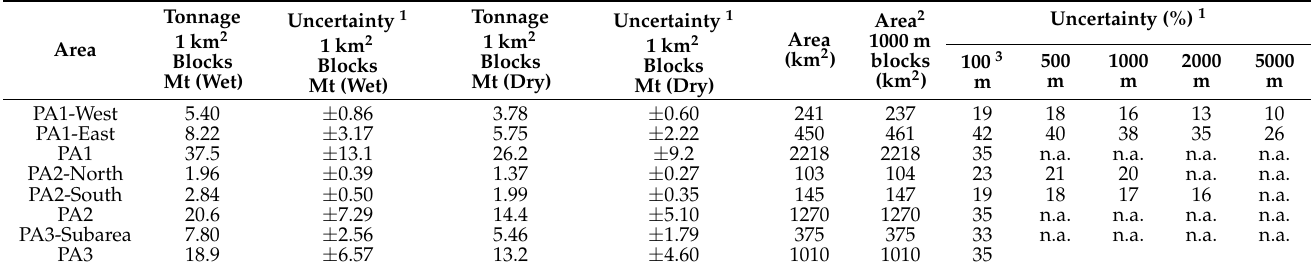
Table 10. Summary of geostatistical resource estimations in prospective areas PA1–PA3.